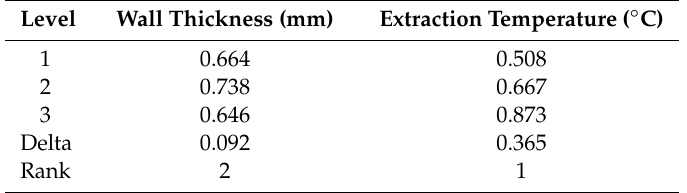
Table 13. Mean values grey relation grade.